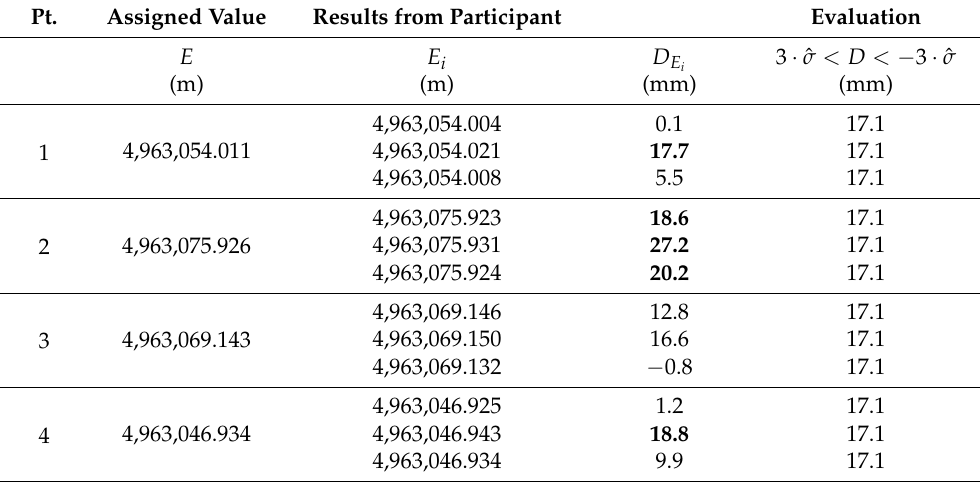
Table 2. Bias D for the coordinate E ( i = AGROS; “Vekom Net”; “GentooARS”).